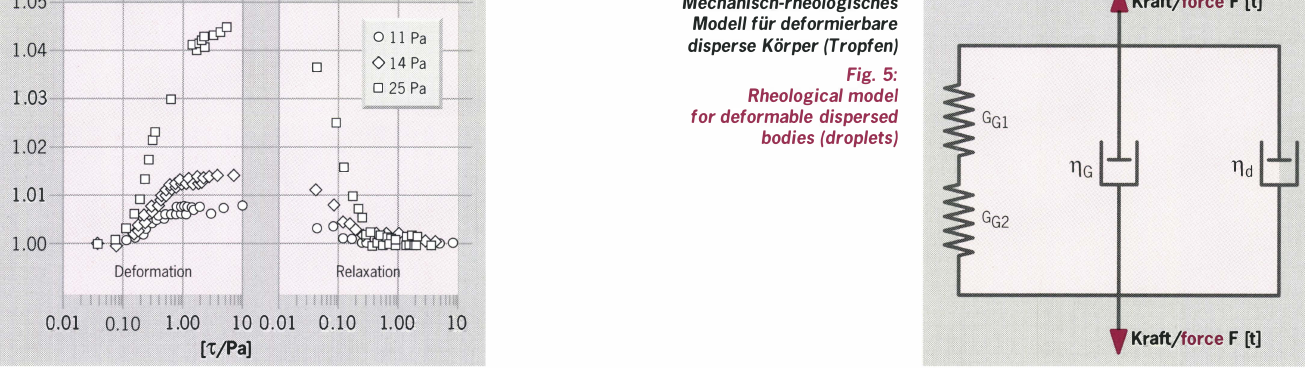
Fig. 4: lnstationary